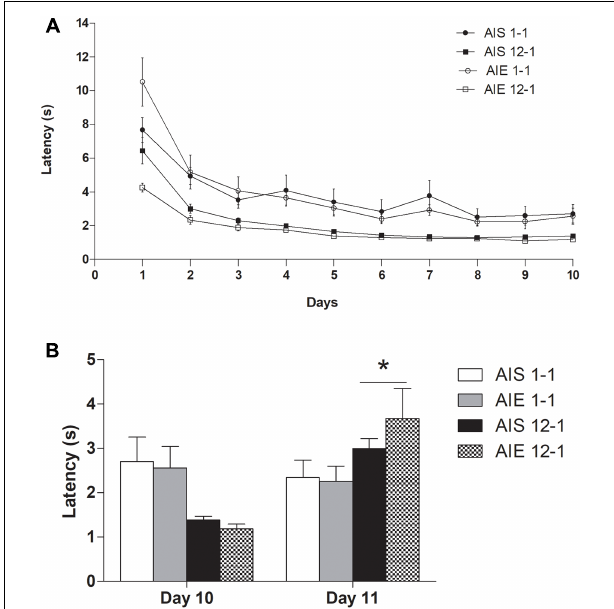
FIGURE 1 | (A) Mean latency (s) to reach the goal-box on each of the training sessions in the straight alley in preshift phase and (B) in postshift phase in groups AIE12-1, AIE1-1, AIS12-1, and AIS1-1. All values are means ± SEM. ∗ p <